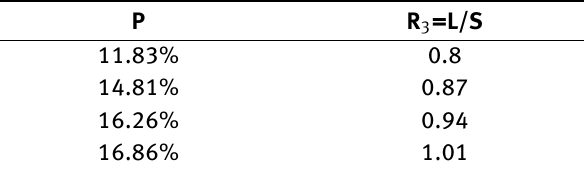
Figure 3: Plan plan